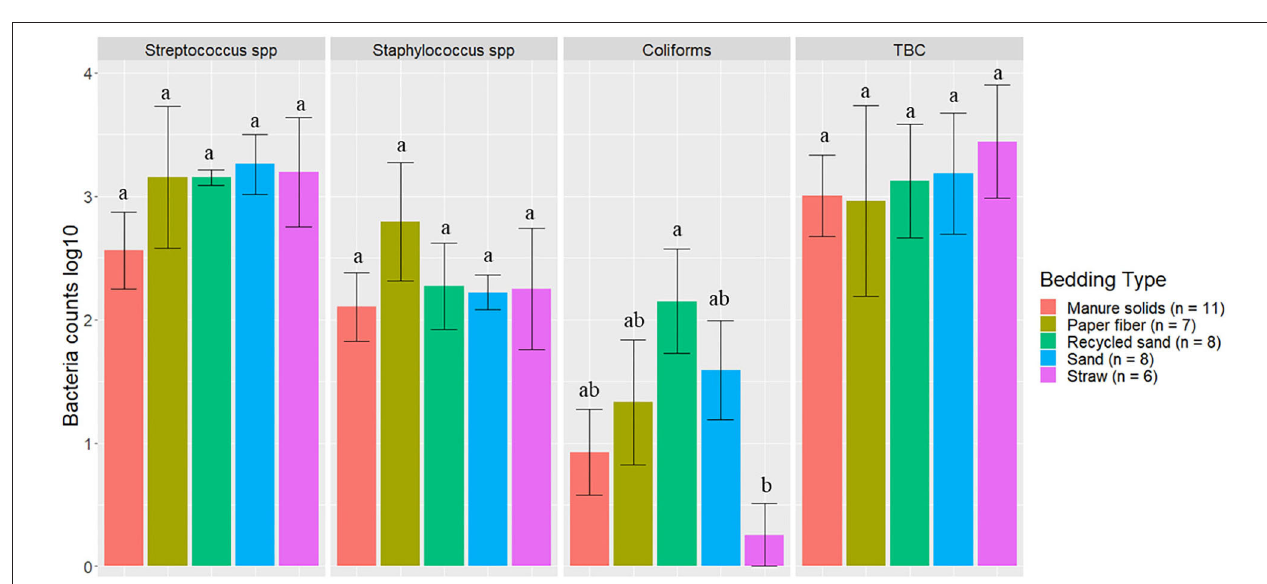
FIGURE 7 | Average bacteria counts (log10 CFU/ml) in milk samples collected monthly (unless milk had been picked up prior to arrival for follow up visit) from the BT after mechanically agitating the milk for at least 5min until sufficient homogeneity is obtained from five conveniently selected New York dairy herds using one of five bedding materials in lactating pens. Error bars represent SD. TBC = total bacteria count. When no bacteria were identified, a value of log 10 + 1 CFU/ml was given, assuming that at least 10 CFU were present.